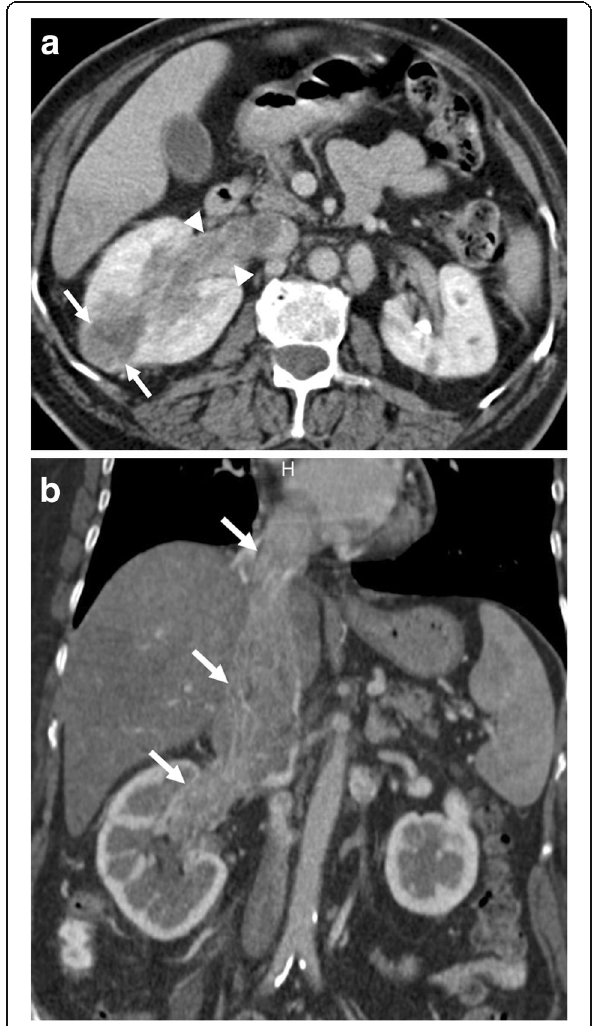
Fig. 11 A 66-year-old female with no significant past medical history presented with right flank pain, hematuria, and lower extremity edema. a Axial plane postcontrast CT image shows peripherally located, ill-defined, heterogeneously enhancing solid mass (arrows) within the right kidney parenchyma suggestive for RCC. There was tumor extension into the right renal vein (arrowheads). b Coronally reformatted postcontrast CT image demonstrates infiltrative, expansile, heterogeneously enhancing tumor thrombus extending from the right renal vein to the IVC and the right atrium (arrows)